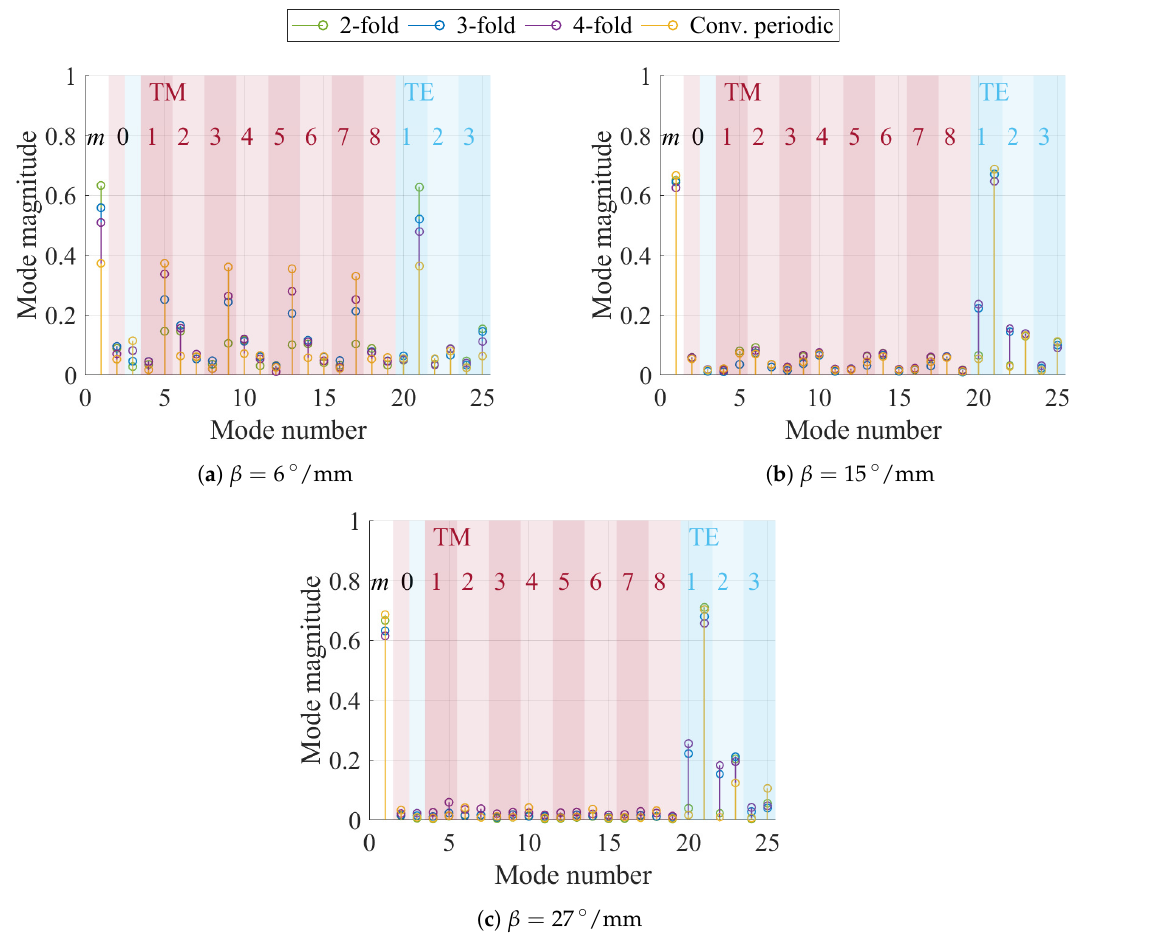
Figure 5. Magnitudes of the mode coefficients for different phases: ( a ) β = 6 ◦ /mm, ( b ) β = 15 ◦ /mm, and ( c ) β = 27 ◦ /mm. The dimensions are the same as in Figure 4.